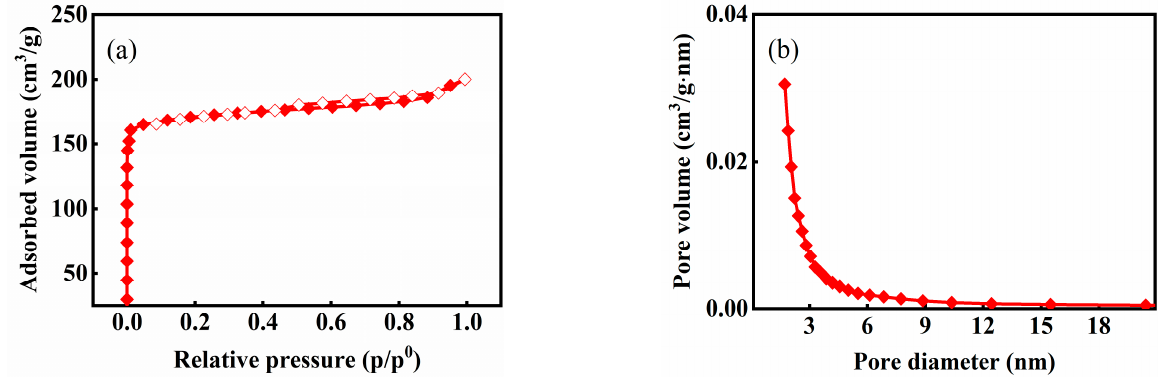
Figure 3. Nitrogen adsorption–desorption isotherm ( a ) and pore size distribution curve ( b ) of MAC.